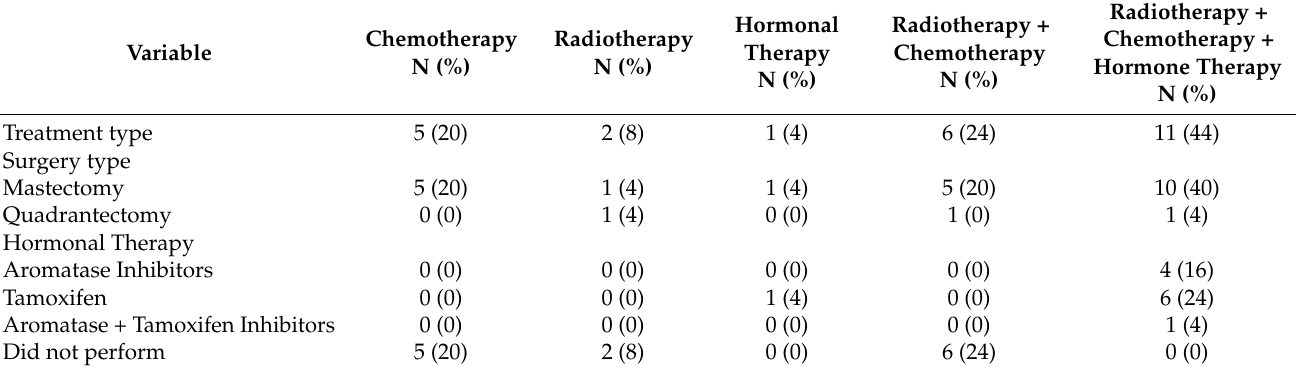
Table 2. Clinical characteristics of study participants organized by treatment